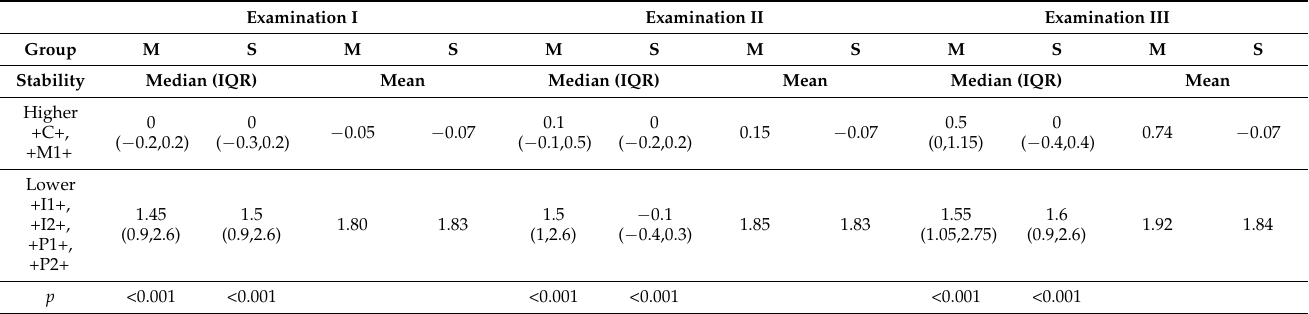
Table 3. Statistical analysis of the intra-group PTV differences between the teeth demonstrating higher and lower stability.